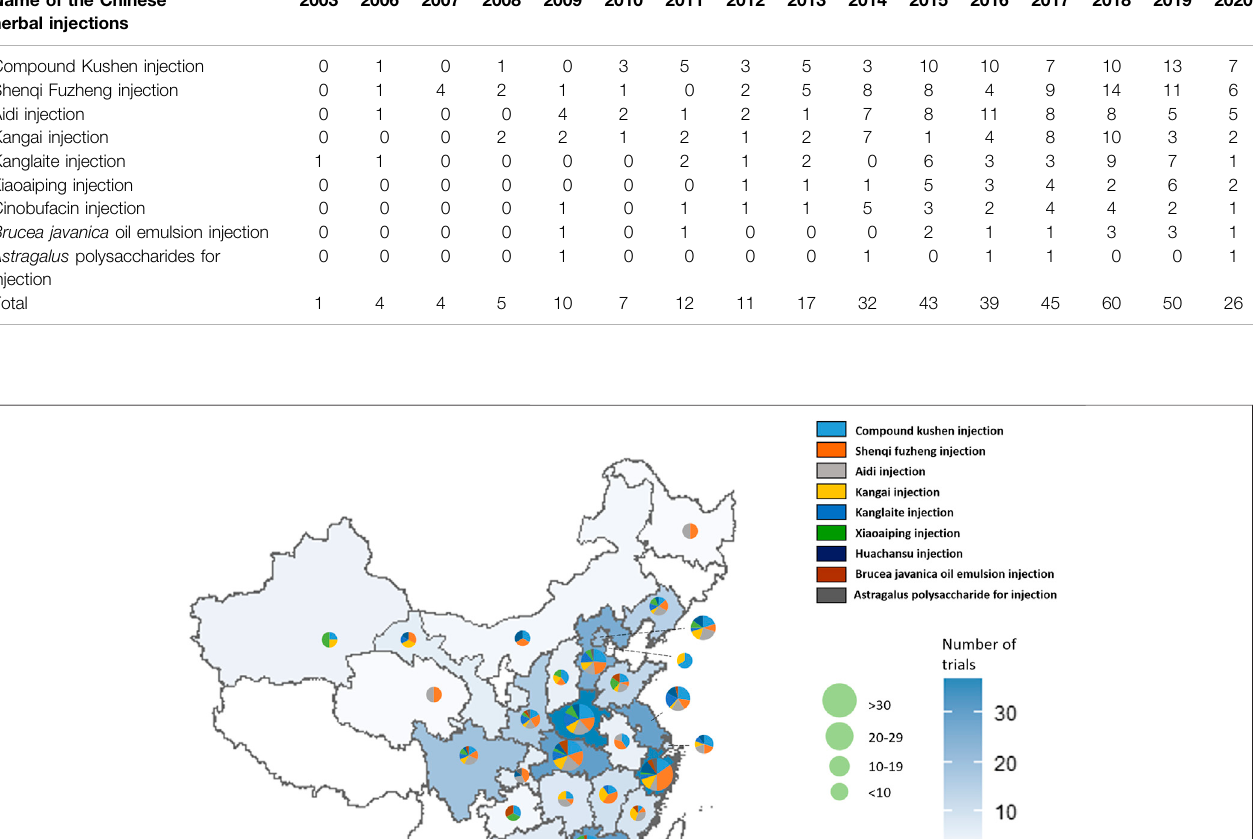
TABLE 3 | The numbers of RCTs on ten herbal injections used in cancer care. Name of the Chinese herbal injections Compound Kushen injection